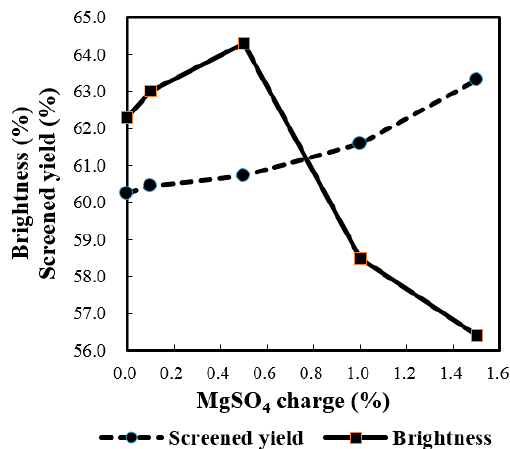
4 charge. Higher than 0.5%